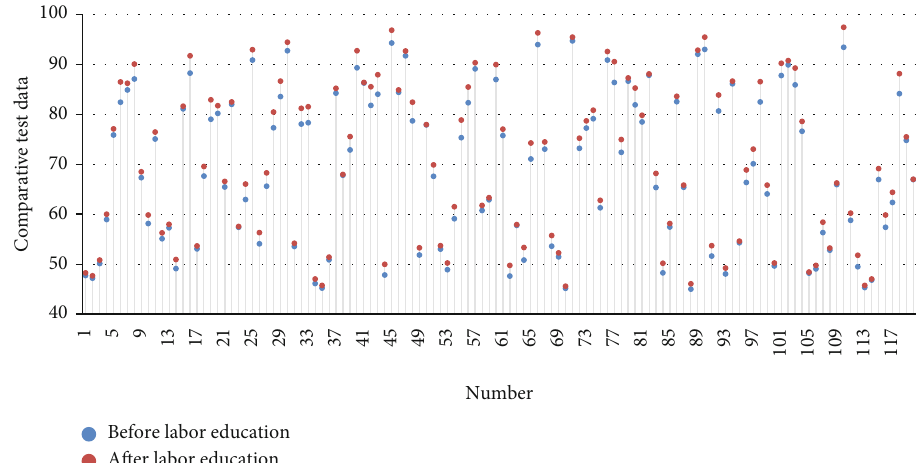
Figure 9: Comparison of the degree of learning e ff